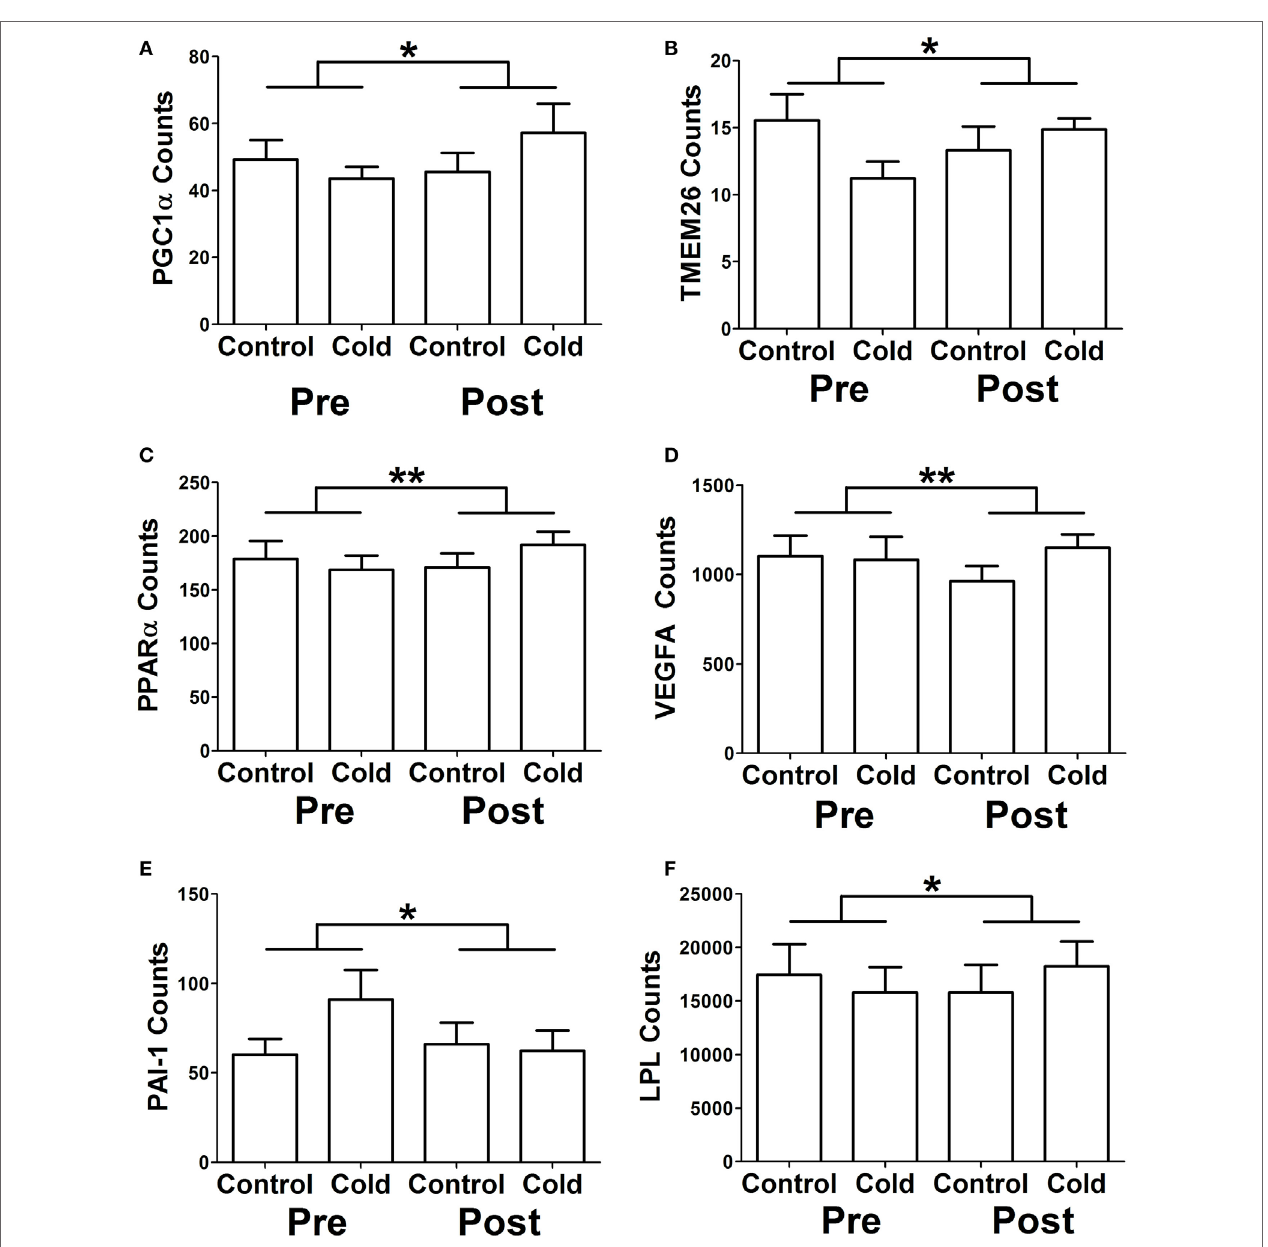
FiGUrE 2 | KDT501 treatment alters the subcutaneous white adipose tissue (SC WAT) transcriptional response to cold exposure. The Nanostring nCounter system was used to measure gene expression in SC WAT of subjects treated before and after 1 month KDT501 treatment. a-F) Genes that had a different response to the cold stimulus were identified as described in the Section “Materials and Methods.” Data represent the mean ± SEM ( n = 9); data in all panels were analyzed by a paired, two tailed Student’s t -test of the change in gene expression by cold before and after KDT501 treatment (* P < 0.05; ** P <